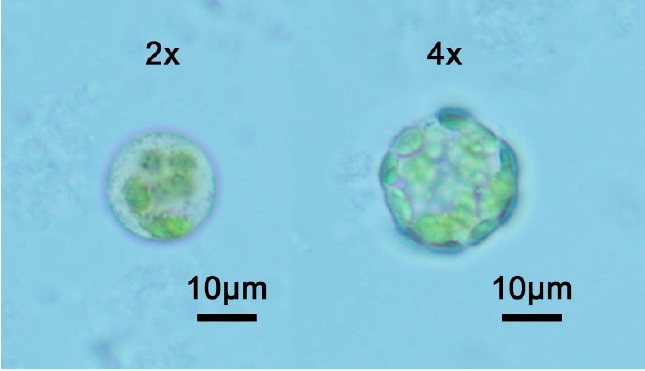
Figure 2. Microscopic observation of protoplasts of different ploidy watermelons. Bars 10 μ m.